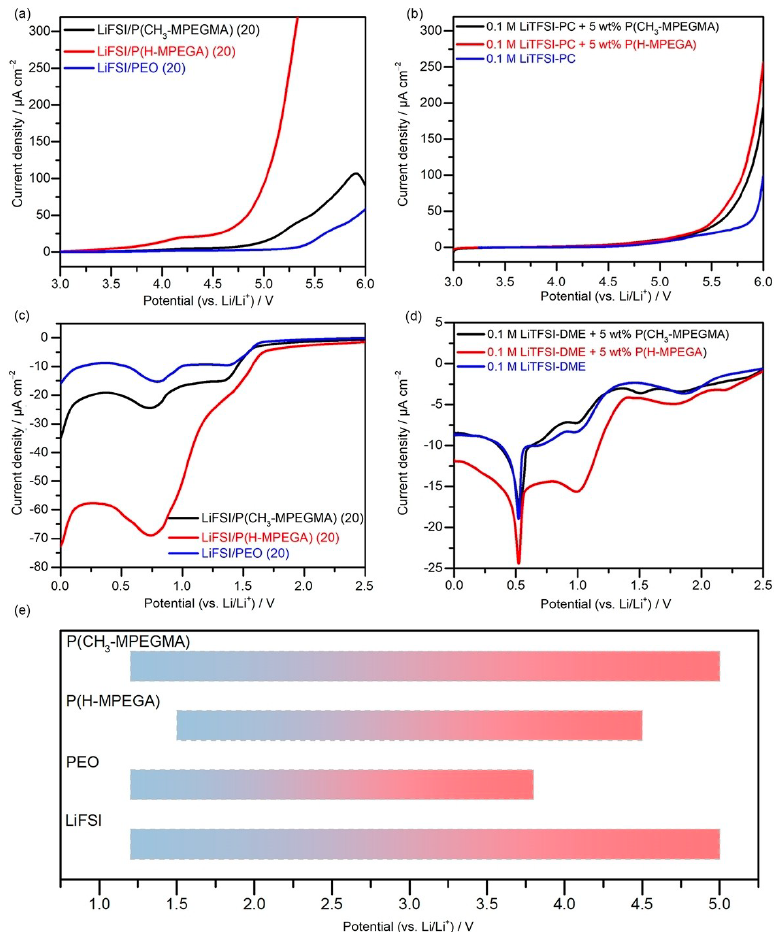
Figure 6. Electrochemical properties of the comb-like SPEs. ( a ) Linear sweep voltammograms (LSV) measured on stainless electrode for LiFSI/poly(methoxy-polyethylene glycol methacrylate) (P(CH 3 -MPEGMA)), LiFSI/poly(methoxy-poly-ethylene glycol acrylate) (P(H-MPEGA)), and LiFSI/PEO at a fixed salt concentration of [EO]/[Li + ] = 20 (temperature: 80 °C; scan rate: 0.5 mV s -1 ). ( b ) LSV profiles measured on Pt electrode for the liquid electrolytes of 0.1 mol L -1 LiTFSI-PC with or without addition of comb-like polymers (temperature: 25 °C; scan rate: 0.5 mV s -1 ). ( c ) LSV profiles measured on stainless electrode for the three SPEs (temperature: 80 °C; scan rate of 0.5 mV s -1 ). ( d ) LSV profiles measured on Ni electrode for the liquid electrolytes of 0.1 mol L -1 LiTFSI-DME with or without addition of comb-like polymers. ( e ) Schematic electrochemical stabilities diagram of the comb-like polymers and other related electrolyte components. Reproduced with permission from ref. [64]. Copyright 2022 Wiley.